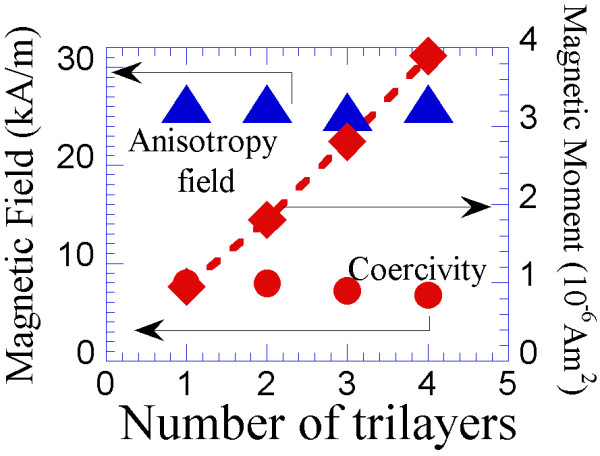
The values of the coercive field, anisotropy field and magnetic moment of the (Co8 nm-54°/Co12 nm-0°/Ta6 nm-54°)nnanolayers. Samples are plotted as a function of n, the number of trilayers, which varies from 1 to 4.